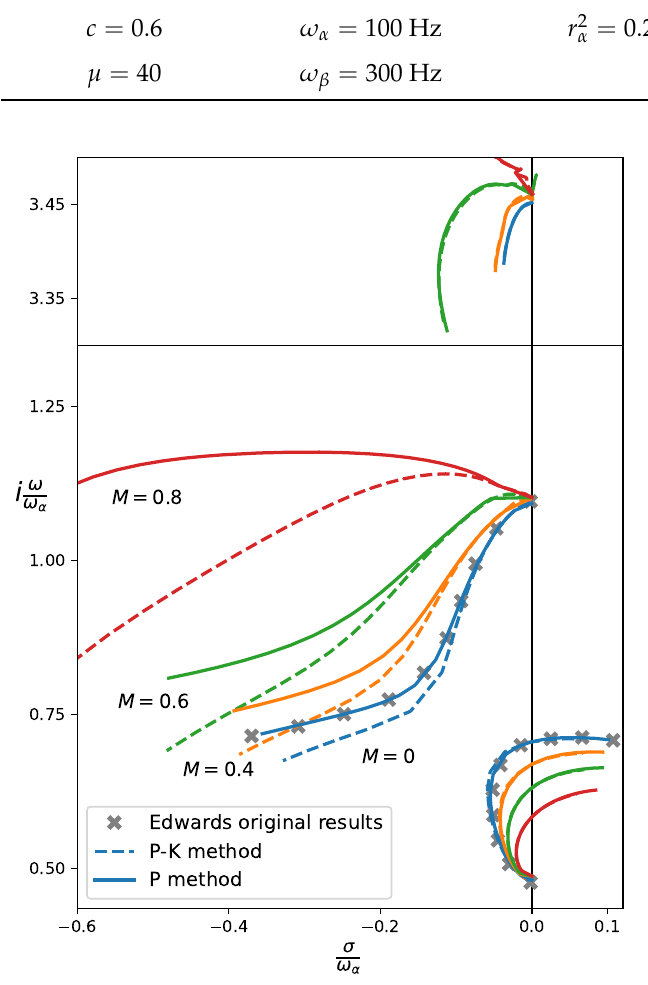
Figure 8. Laplace domain showing the poles for a 3 DOF airfoil as a function of Mach number and